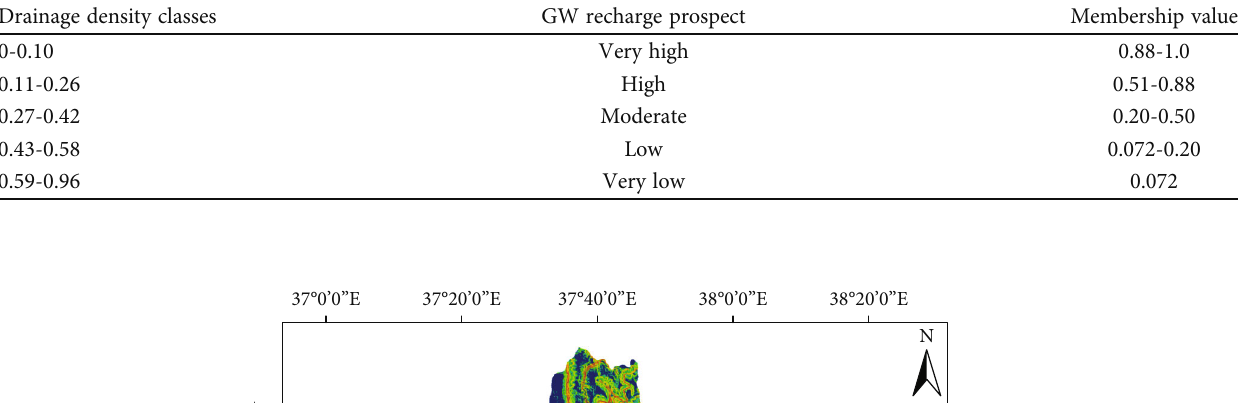
Table 1: Drainage density classes, membership value, and distribution.